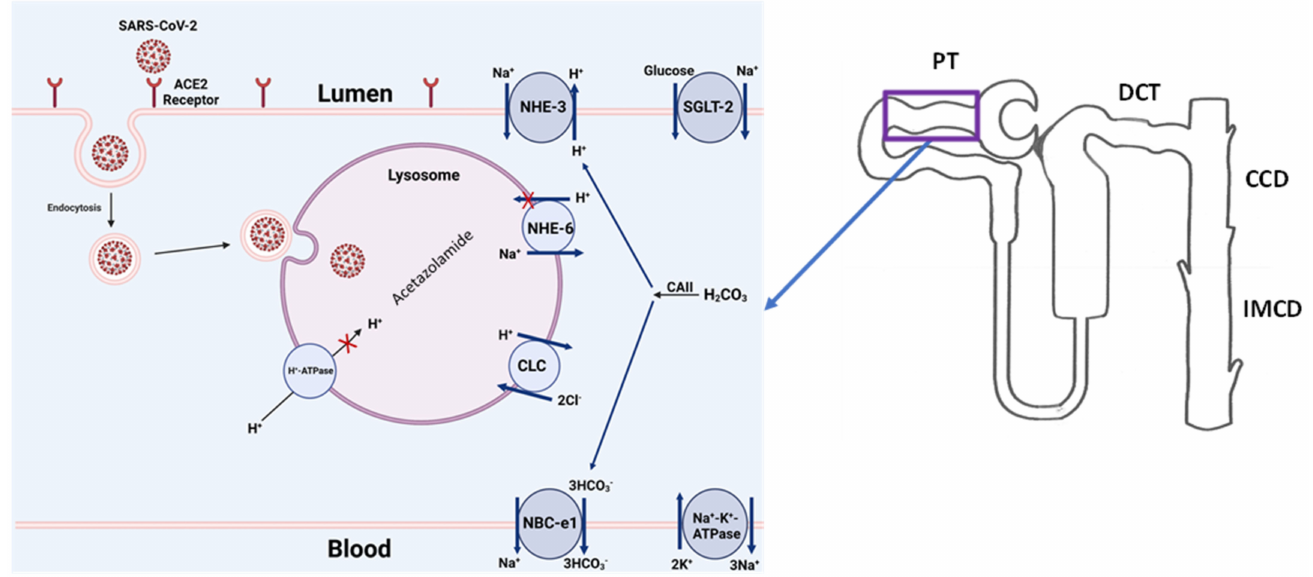
Figure 4. Binding of SARS-CoV-2 with the ACE2 receptor and entry into kidney proximal tubule cells. Proposed schematic diagram depicting the binding of SARS-CoV-2 spike protein to the apical membrane of the kidney proximal tubule cells, followed by the internalization of the virus through endocytosis and its entry into lysosomes. The crucial transporters responsible for lysosomal acidi- fication are shown. The role of carbonic anhydrase inhibitors, such as acetazolamide, in impairing lysosomal acidification via interference with the activity of acid-importing H + -ATPase and NHE-6 is highlighted. The proximal-tubule-specific plasma membrane transporters are shown. Image created with BioRender . PT : proximal tubule ; DCT : distal convoluted tubule ; CCD : cortical colleting duct ; IMCD : inner medullary collecting duct